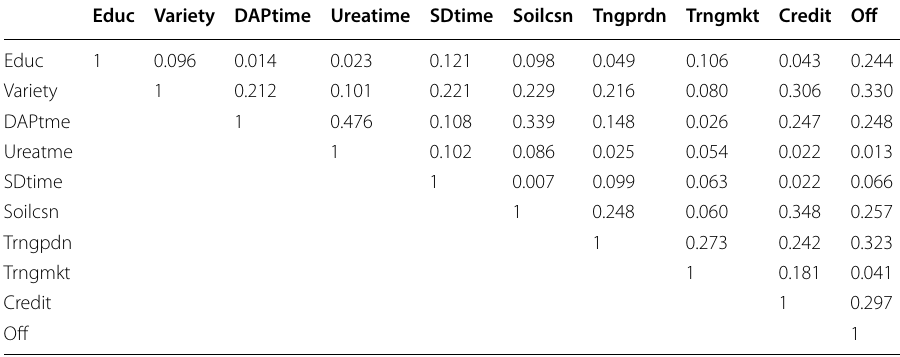
Table 6 Contingency coefficients for hypothesized discrete explanatory variables ( n 150) Source: Computed from Field Survey Data, =